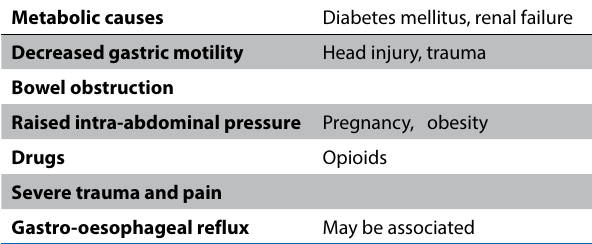
Table 2. Causes of delayed gastric emptying